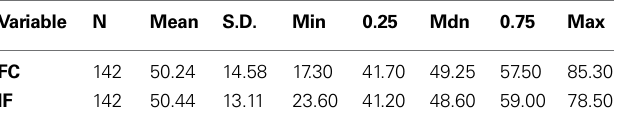
Table 1 | Summary statistics for neuronal percent measures from fl ow cytometry and manual microscope